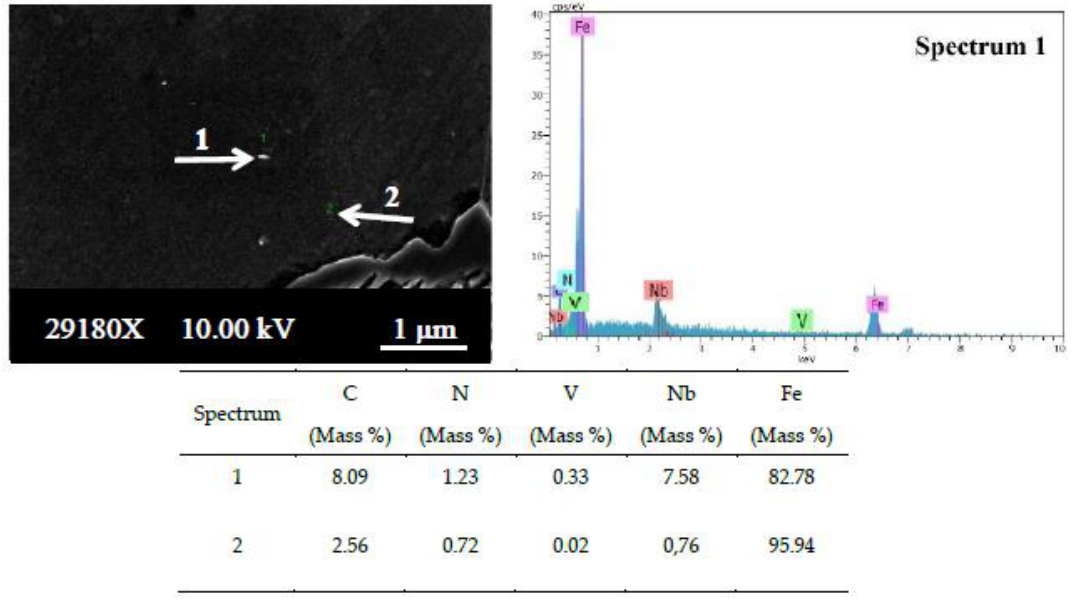
Figure 8. SEM micrographfor Alloy 4 and the corresponding EDS of the indicated points.